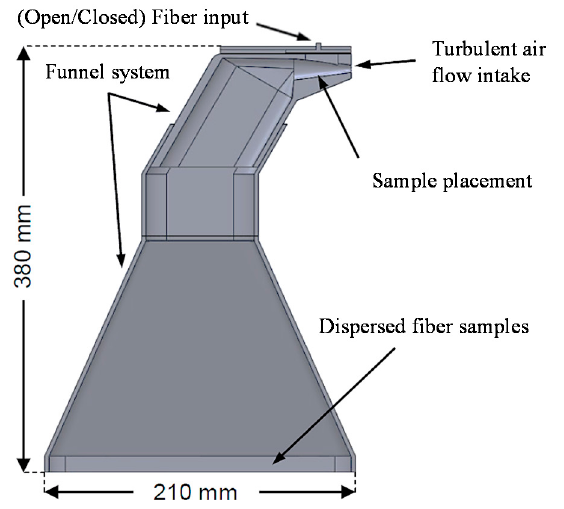
Figure 5. Dispersion chamber after Goris adapted from [17,50].